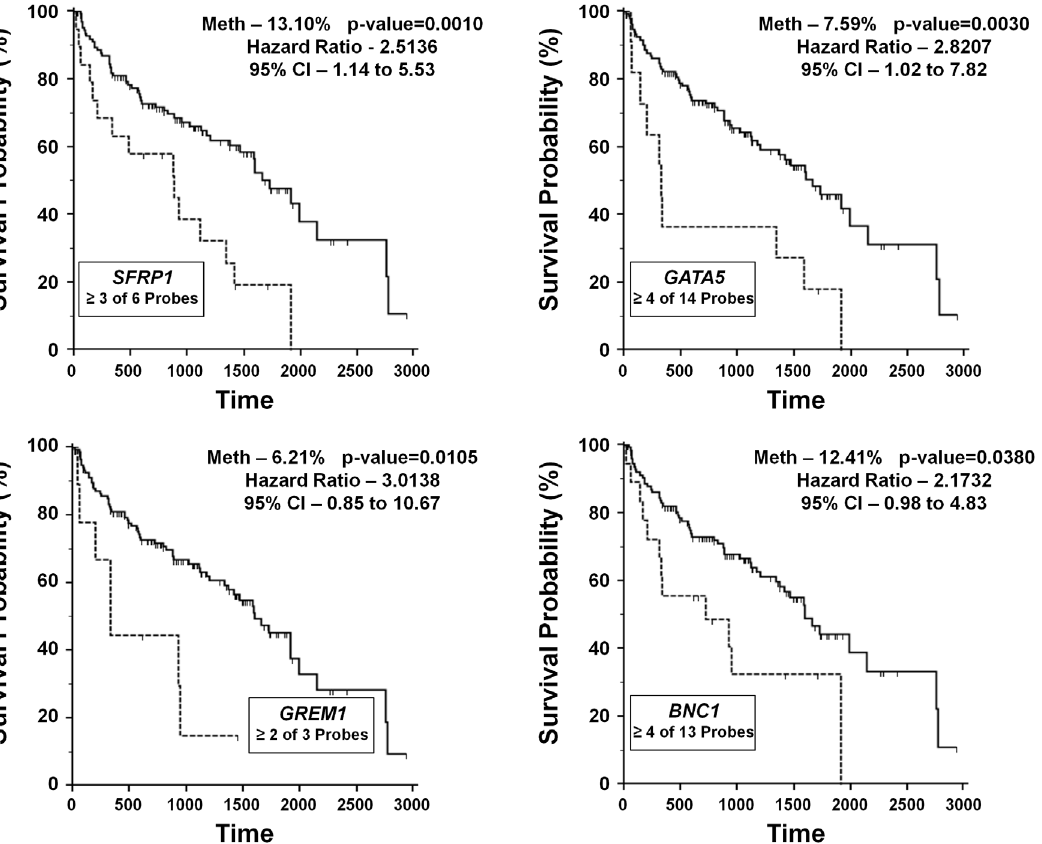
Figure 4. Kaplan-Meier survival curves for the hypermethylated genes from the HumanMethylation450 BeadChip cohort. Kaplan- Meier survival curves were calculated for each of the tumor-specific hypermethylated genes within the HumanMethylation450 BeadChip cohort and these graphs represent the genes for which the p-value remained significant after false discovery rate (FDR) correction for multiple analyses. The percentage of hypermethylation (Meth) is representative of the 145 CCRCC tumor/normal pairs for which clinical information was available. For each gene, the ratio of hypermethylated CpG island probes needed per tumor for it to be considered positive is listed with the gene name.